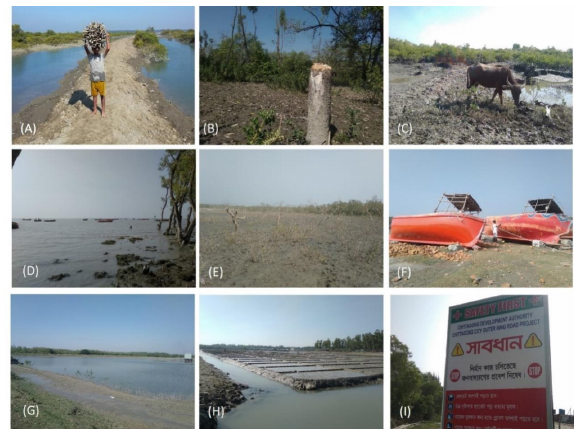
Figure 6. Anthropogenic and natural factors that trigger changes in ecosystem services in the studied south-eastern coastal areas of Bangladesh: ( A ) Collecting firewood, although officially prohibited; ( B ) illegal cutting of a pre-mature mangrove stem; ( C ) feral and domestic animals feed on mangrove twigs and are responsible for disturbing the new germination or establishment of mangrove plants; ( D ) extreme cyclone events frequently destroy the seaward periphery of the mangrove forest; ( E ) land-use changes and destruction of a mangrove: A bare land that was previously covered with mangrove plants; ( F ) coastal space for boat making, repair, net making, or even fish drying; ( G ) conversion of coastal space into shrimp aquaculture ponds; ( H ) conversion of mangrove areas into a salt production unit; ( I ) signboard by the Chittagong development authority declaring the extensive development activities (Photo credit: Shuvo Pal).